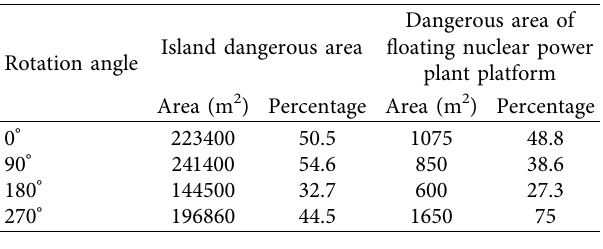
Table 6: The dangerous area and proportion after rotating at the eastern break.